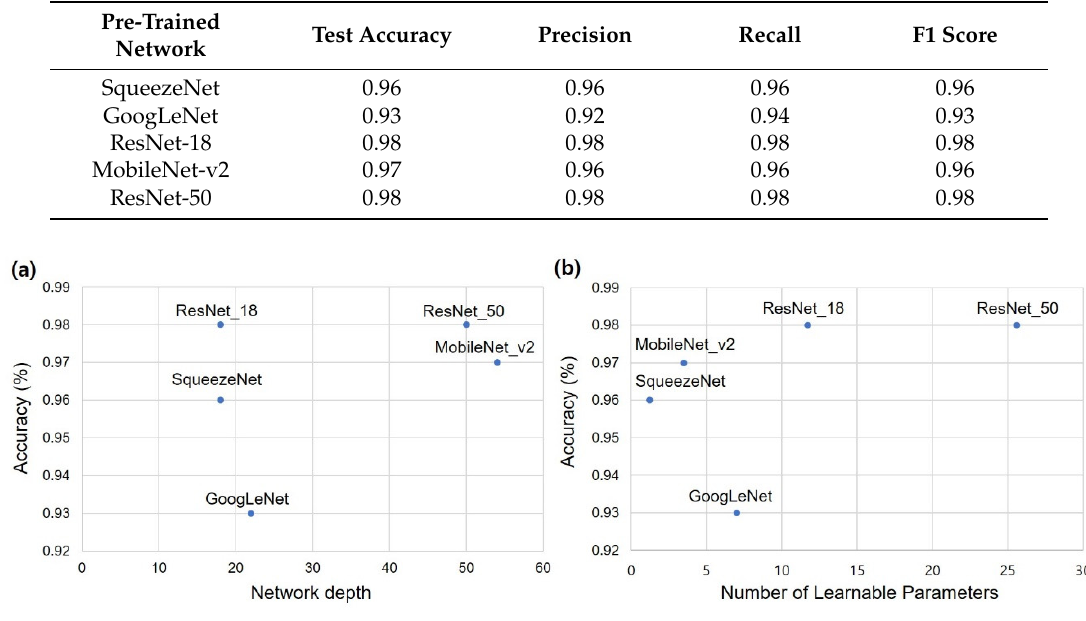
Figure 4. Test accuracy with respect to network depth and number of parameters. ( a ) Network depth, ( b ) Number of parameters.